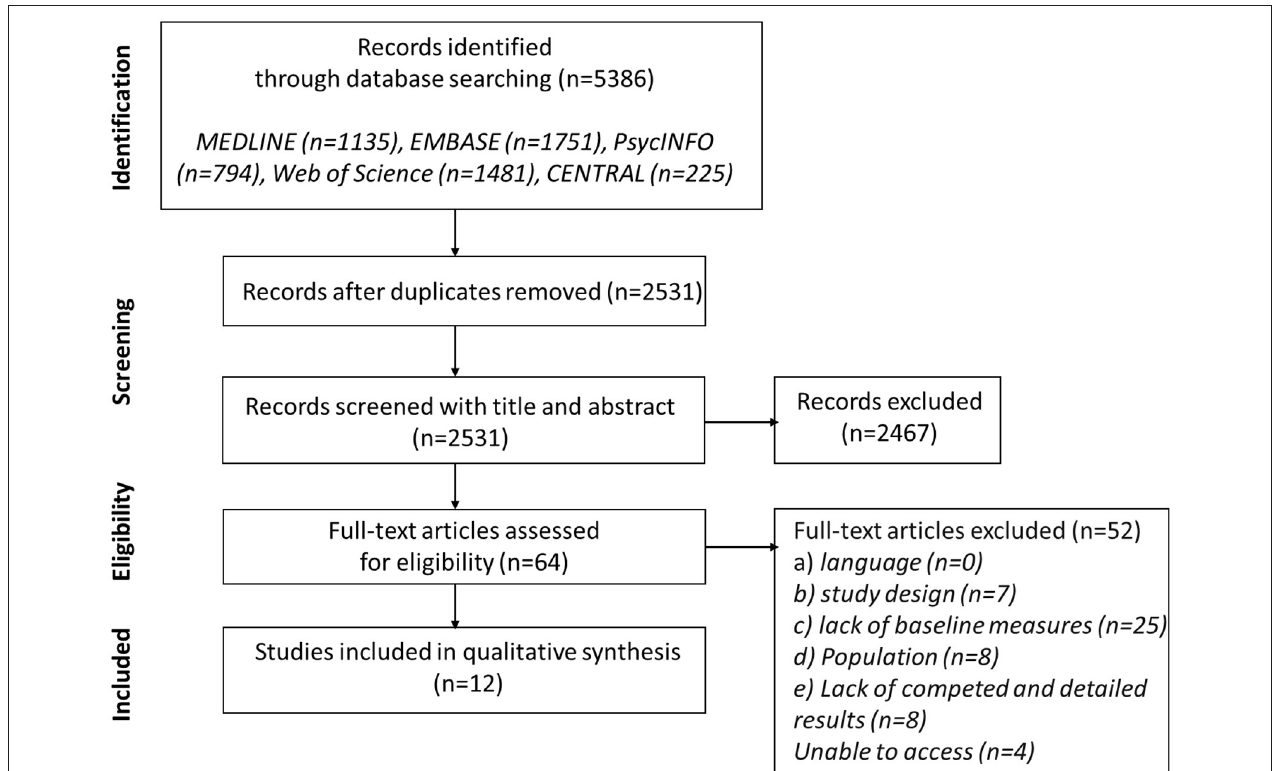
FIGURE 1 | Preferred reporting items for systematic reviews and meta-analysis (PRISMA) flow diagram of